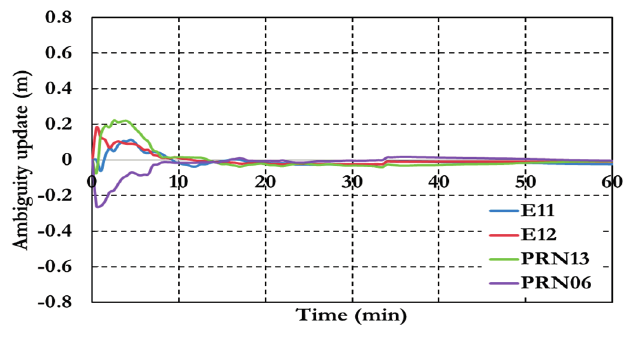
Figure 19. Ambiguity parameters the BSSD PPP loose combination model.